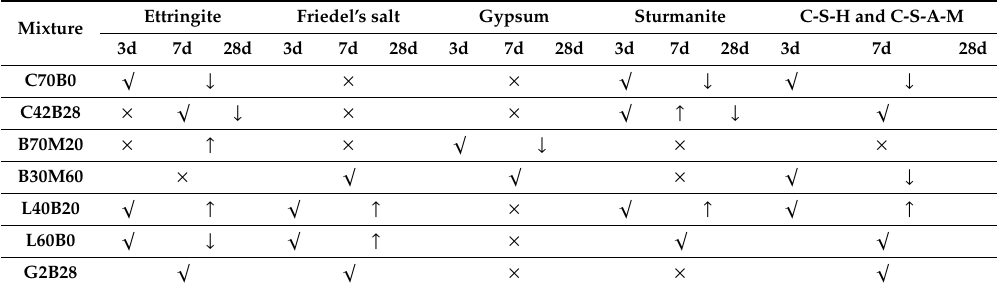
Table 3. Qualitative changes in amount of hydrates of representative mixtures. The notations are as √ follows— : Is present; × : Is absent; ↑ : Increases; ↓ :